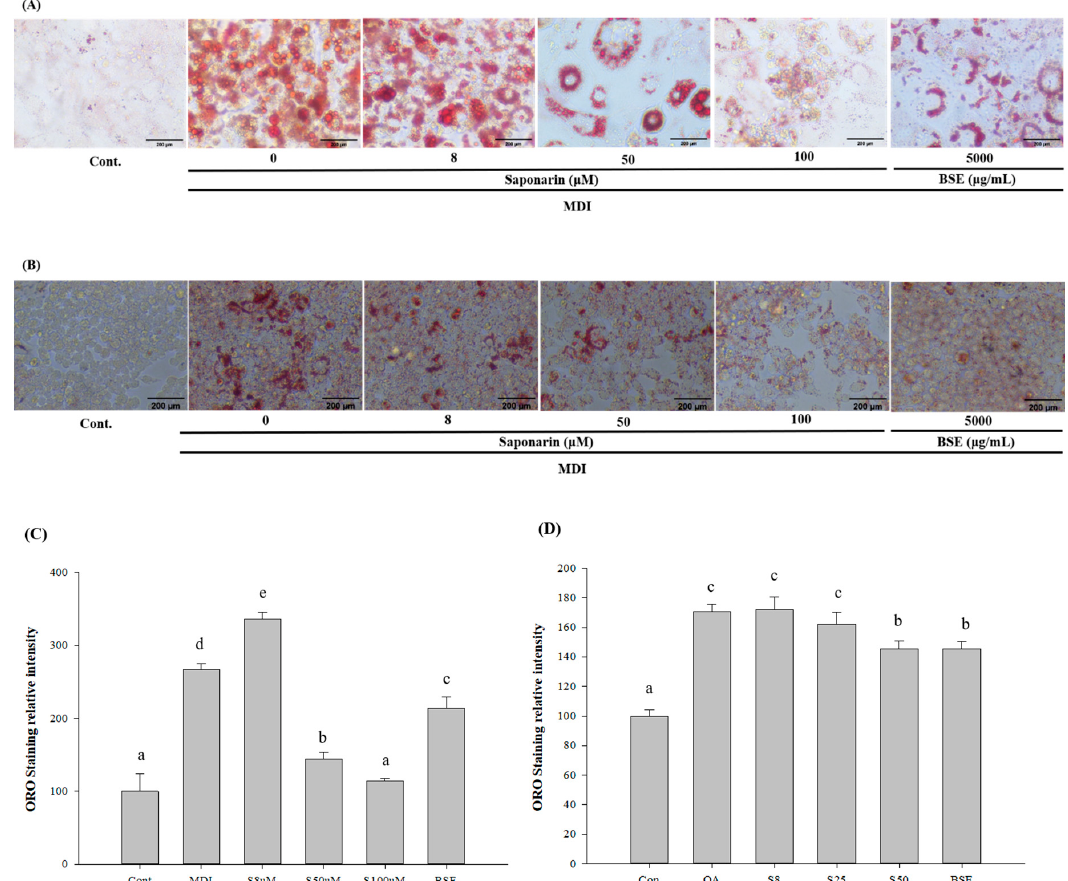
Figure 3. Effect of barley sprout extracts (BSEs) and saponarin on fat accumulation in the 3T3-L1 cells and HepG2 cells. ( A ) Oil red O staining of the intracellular triglycerides in the 3T3-L1 cells. The 3T3-L1 cells were treated with BSE (500 μ g/mL) or saponarin (0, 8, 50, and 100 μ M) during differentiation. The assays were performed on fully differentiated adipocytes (day 12). The selected images of three independent experiments. ( B ) Oil Red O staining of the intracellular triglycerides in the HepG2 cells. HepG2 cells were treated with BSE (500 μ g/mL) or saponarin (0, 8, 25, and 50 μ M) during fat accumulation (24 h). The selected images of three independent experiments. ( C ) Relative density of the lipid contents in the 3T3-L1 cells. ( D ) Relative density of the lipid contents in the HepG2 cells. Statistical analyses were performed using Duncan’s multiple range test one-way analysis of variance (ANOVA) (a, b, c, d, e). Data are expressed as mean ± SEM of three independent experiments. abc: Different superscripts indicated mean difference between groups significant at p < 0.05. HepG2 cells were treated with oleic acid to induce NAFLD, and oil red O staining was used to measure the potential inhibitory e ff ects of the BSE and SA on fat accumulation. In the